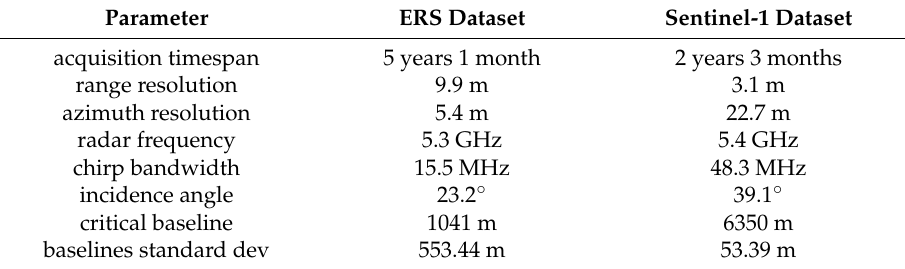
Table 3. Comparative synthetization of the dataset’s acquisition parameters .